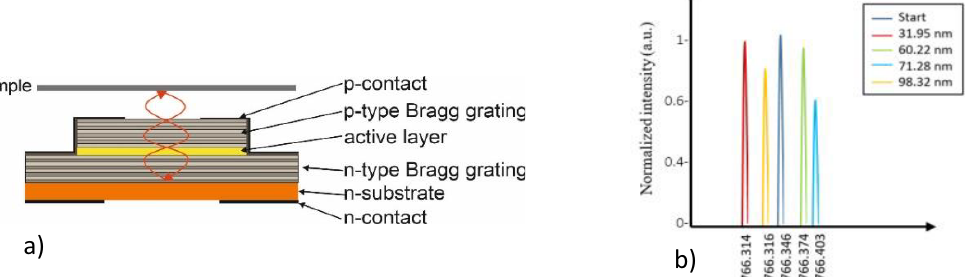
Fig. 1 : Cross section of a standard VCSEL showing the active layer and the distributed Bragg reflection (DBR) grating which are essential parts of the developed system. The sample next to the emission window reflects the light partially back into the resonator where it interacts with the internal modes forming a coupled resonator